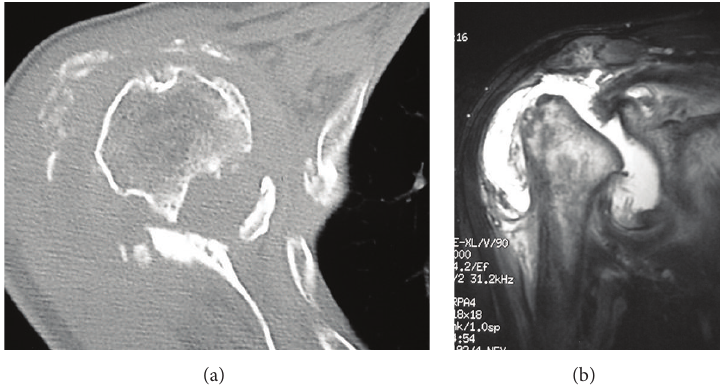
Figure2:Case 1.Imagingoftherightshoulder4monthsafterthefirstvisit.(a)Anaxialcomputedtomographyviewdemonstratesadestroyed humeral head, displaced bony fragments outside of the greater tuberosity, and destruction of the glenoid. (b) T2-weighted magnetic resonance image (oblique coronal plane) shows the joint destruction, joint effusion, and a rotator cuff